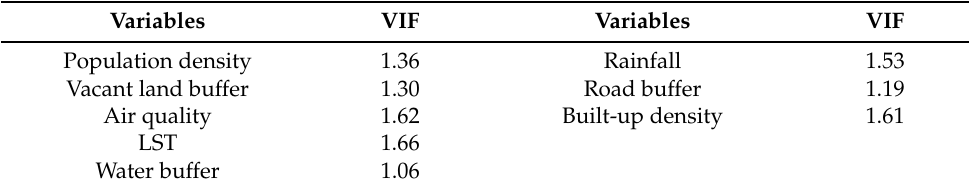
Table 3. Multicollinearity analysis showing VIF values less than five for all the driving factors of GI transformation.